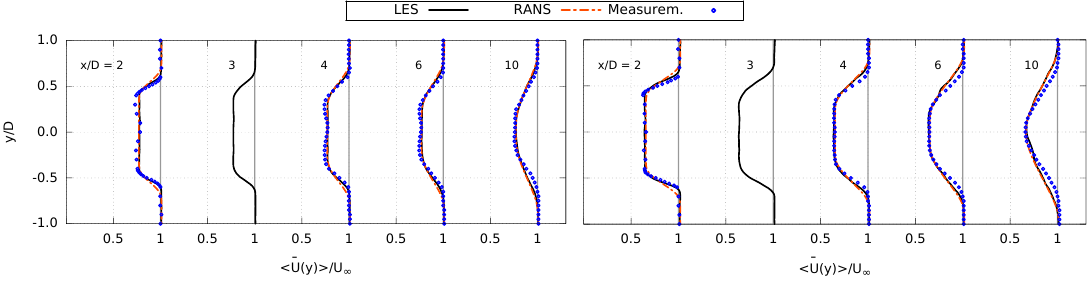
Figure 5. Vertical profiles of velocity deficit behind the disk C T = 0.42 ( left ) and C T = 0.62 ( right ), Ti3 case. RANS results in all figures are by Sumner et al. [17].